Question: Sum up the contents of this chart in one sentence.
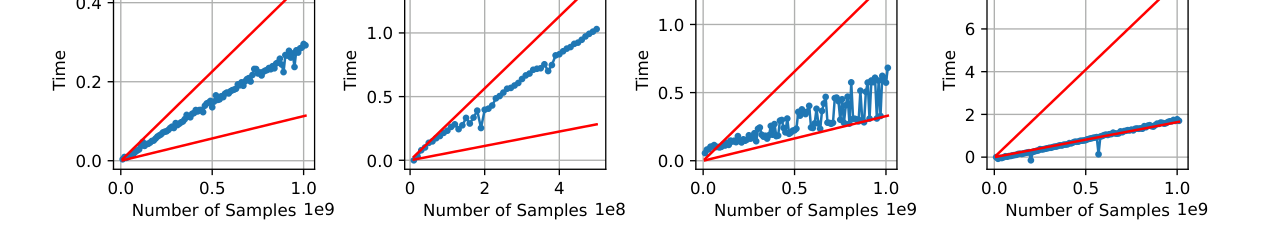
Answer: The quality of performance prediction for ScaleGPM’s NS Engine. The red lines are our predictions, while blue dots are actual time.